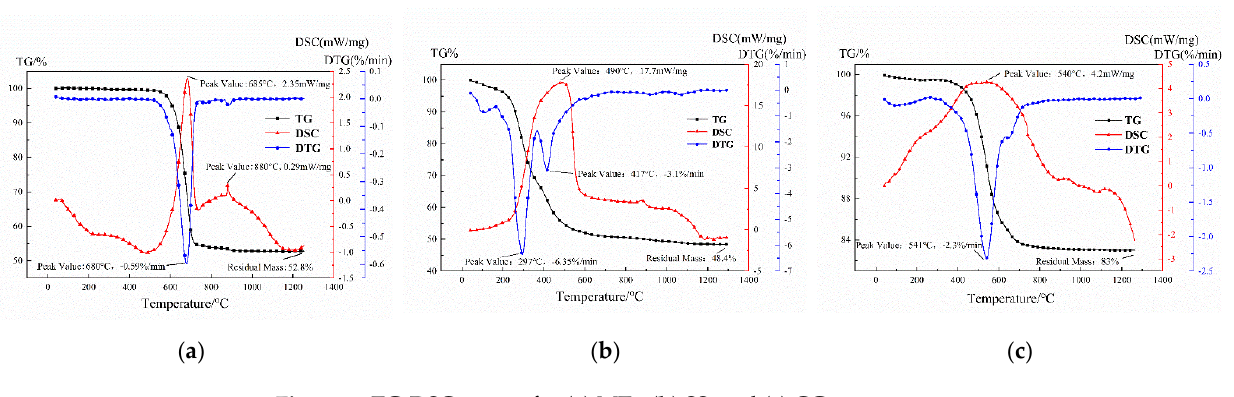
Figure 2. TG-DSC curves for ( a ) MTs, ( b ) SS, and ( c ) CG